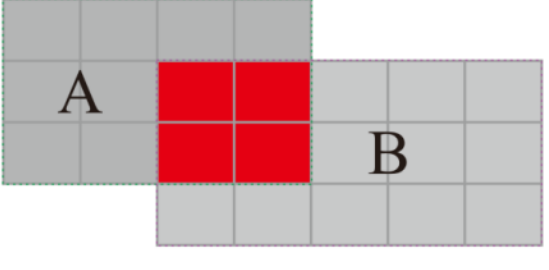
Figure 7. Degree of overlap.